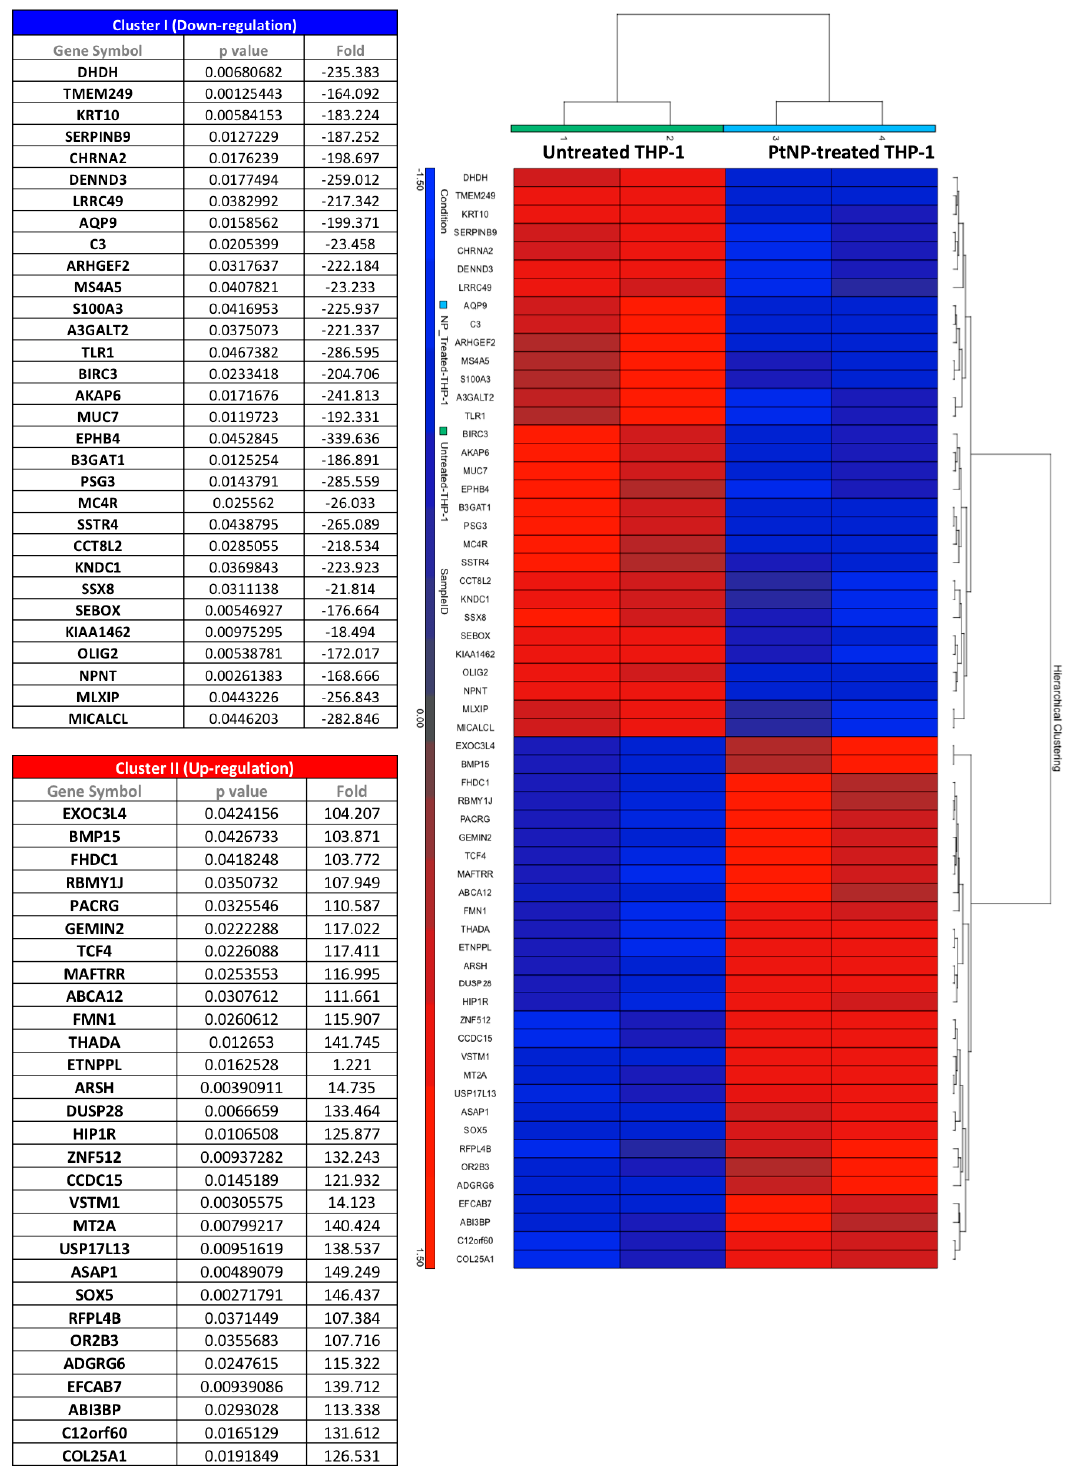
Figure 6. Gene expression—Hierarchical gene clustering. Gene transcription after 6 h 50 µ g/mL 5 nm PtNPs treatment evaluated by microarray analysis. The heat map shows significant changes in a group of selected genes due to PtNPs exposure in THP-1 cells. Two clusters were detected, one due to down-regulation of the genes (blue) and other due to up-regulation of the genes (red) in NP-treated vs. NP-untreated cells. Fold change and p -value of the genes in the clusters are given on the